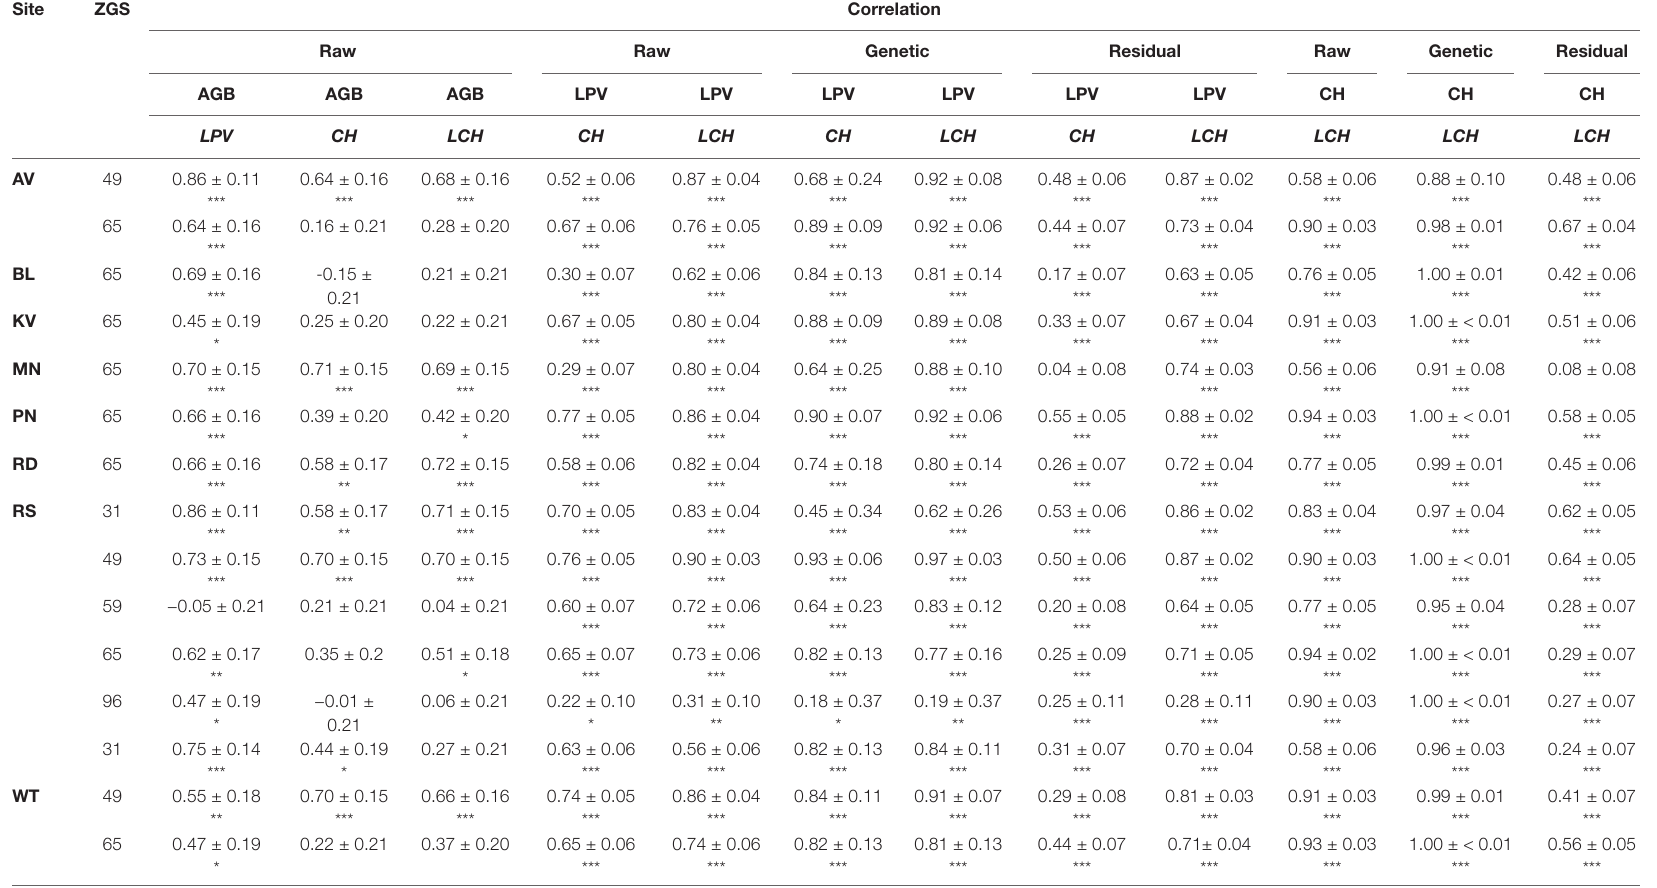
TABLE 4 | Correlations between traits, plus or minus standard error, at each site and sample time (ZGS), measured in the current